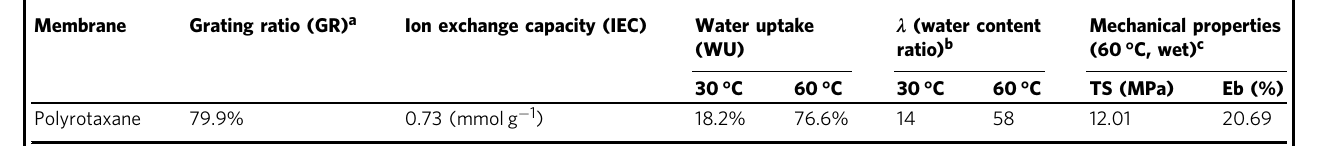
Table 1 Properties of the polyrotaxane proton exchange membranes Membrane Grating ratio (GR) a Ion exchange capacity (IEC)